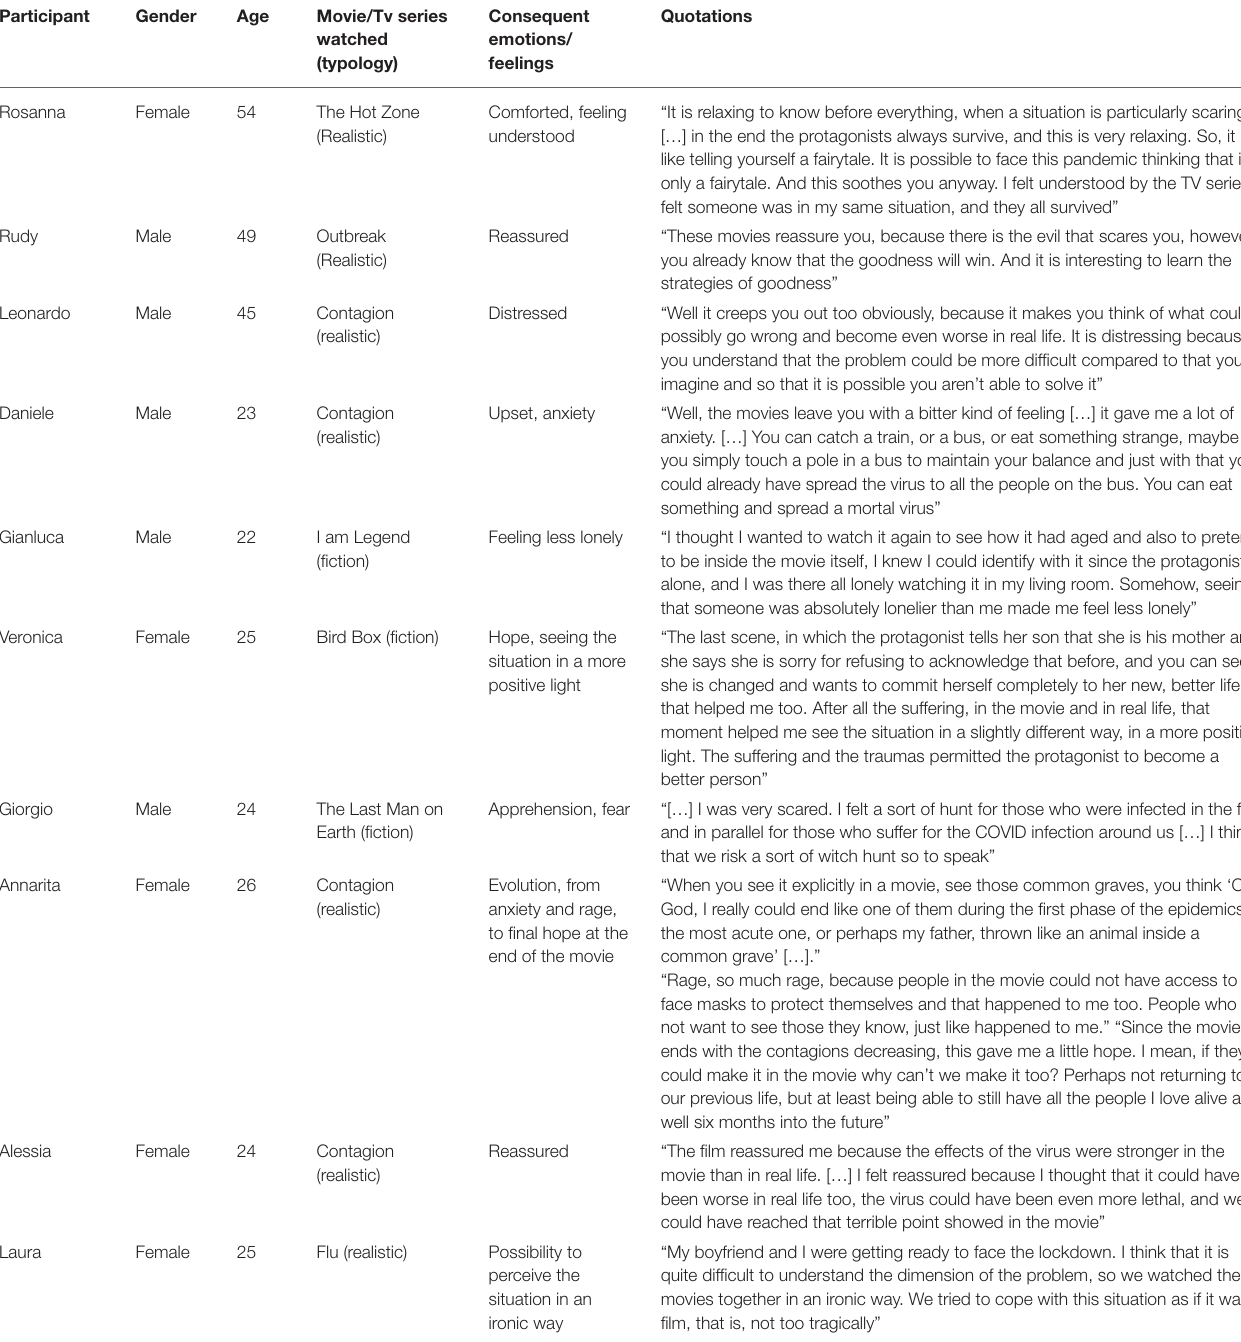
TABLE 2 | Feelings and emotions after the